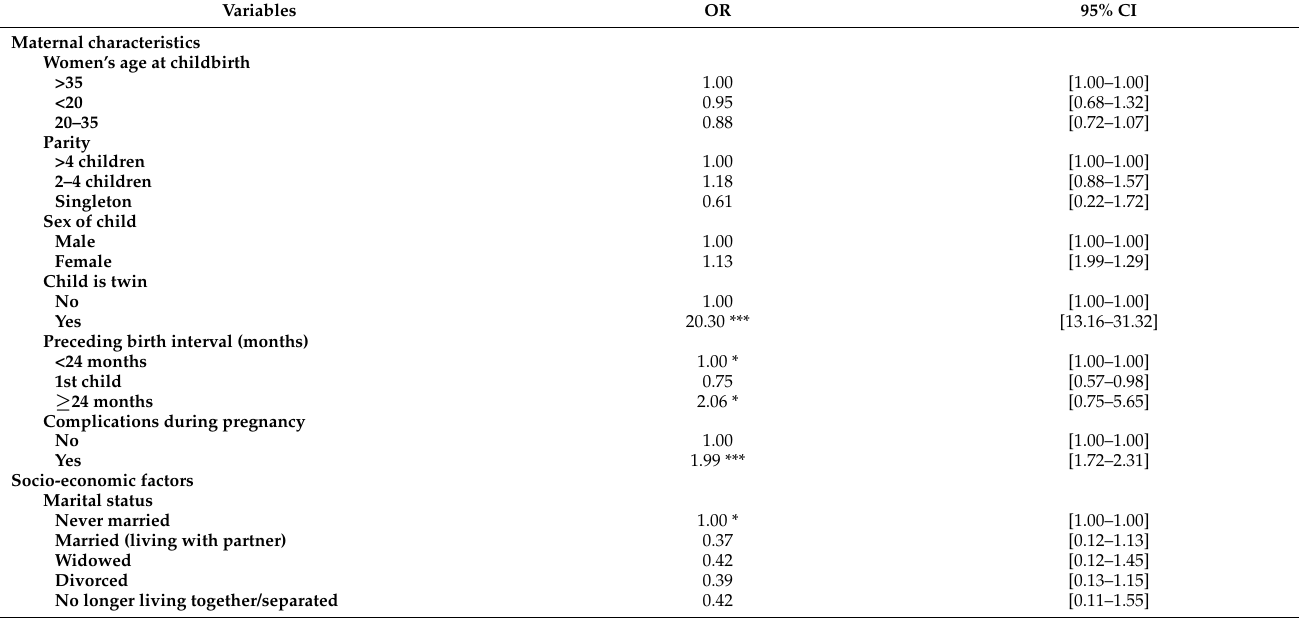
Table 2. Multivariate analysis of maternal characteristics and socio-economic factors with LBW among women of childbearing